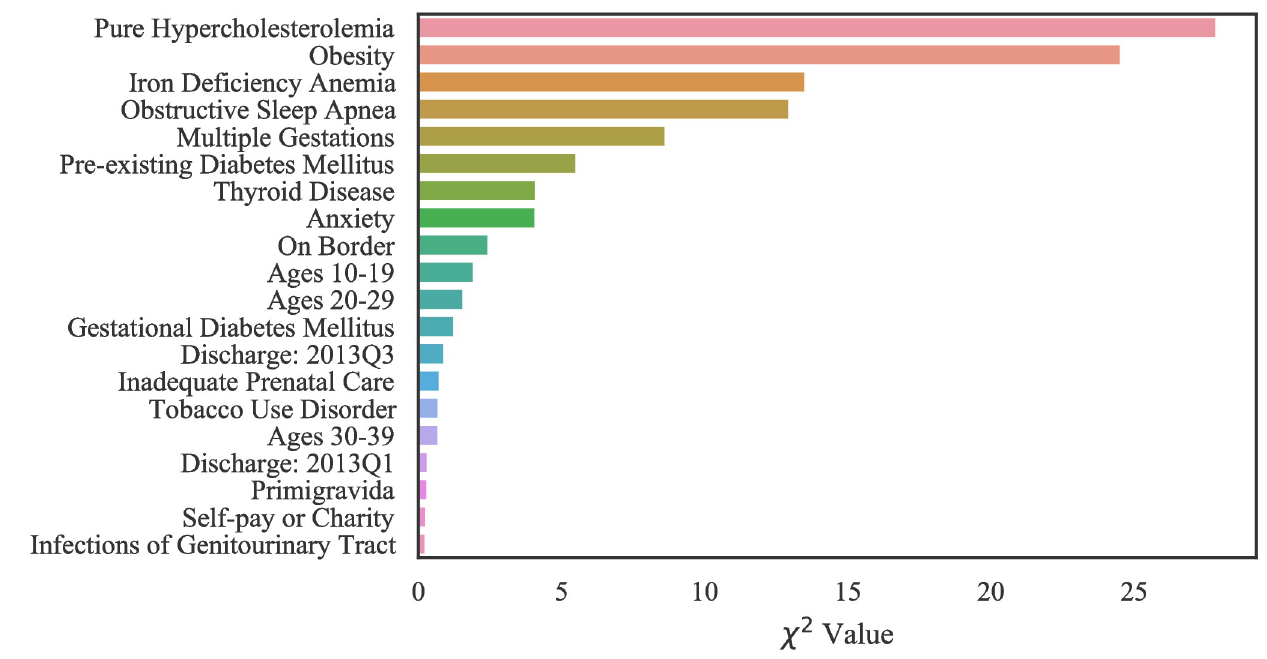
Fig 12. Feature ranking for the Texas Native American